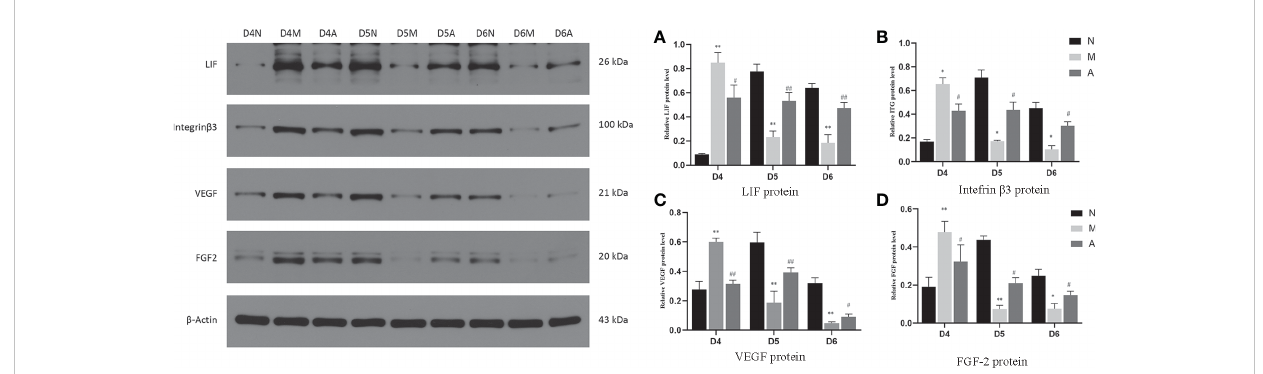
FIGURE 7 The expression of LIF (A) , integrin b 3 protein (B) , VEGF (C) , and FGF-2 (D) protein in the endometrium by West-bolt. *or** represents that there is signi fi cant difference between M and N groups ( P < 0.05 or P < 0.01), #or ## represents that there is signi fi cant difference between A and M groups ( P < 0.05 or P < 0.01). LIF, Leukemia inhibitory factor; VEGF, Vascular endothelial growth factor; FGF-2, Fibroblast growth factor 2; D, The embryo day; N, Normal group; M, Model group; A, Acupuncture group.